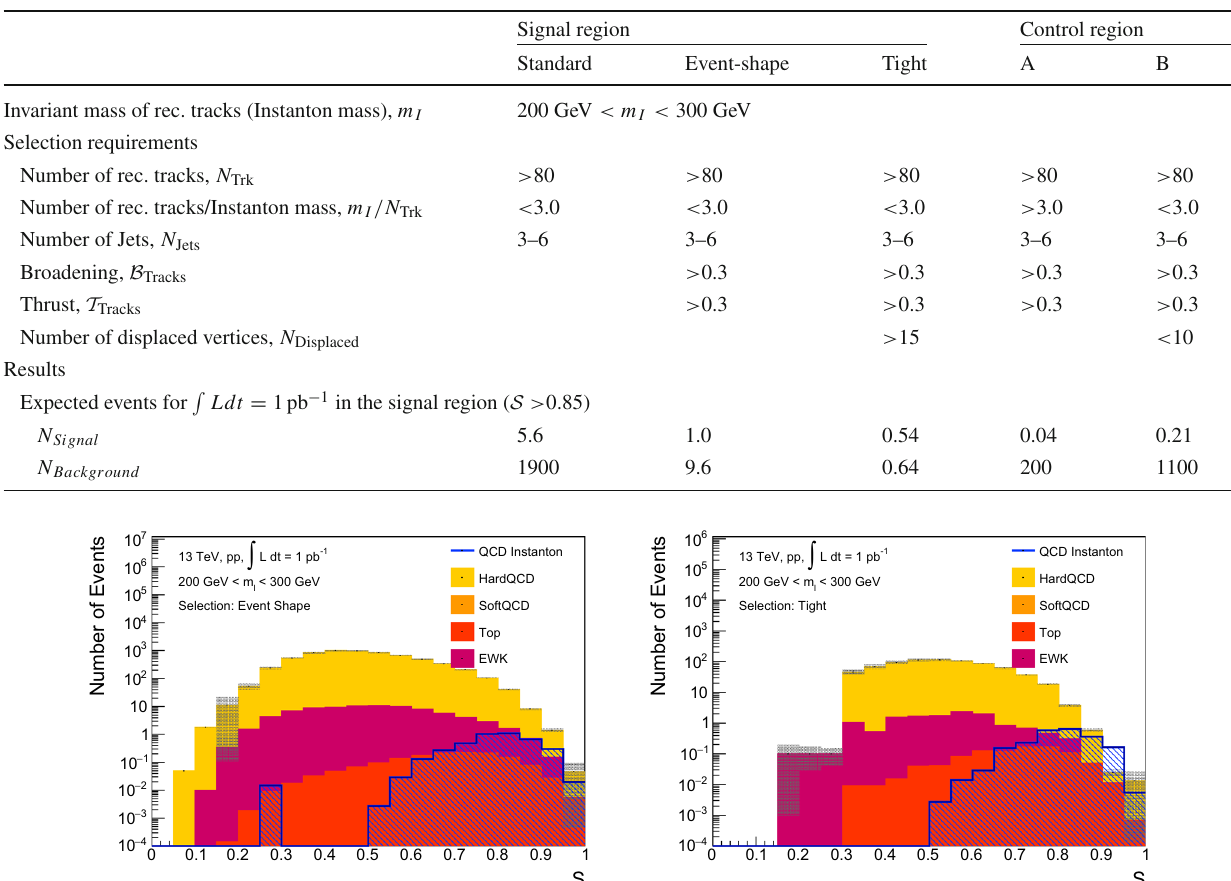
Table 5 Overview of the standard and tight signal selection as well as the definition of two control regions aiming at very low Instanton masses (200 GeV < m